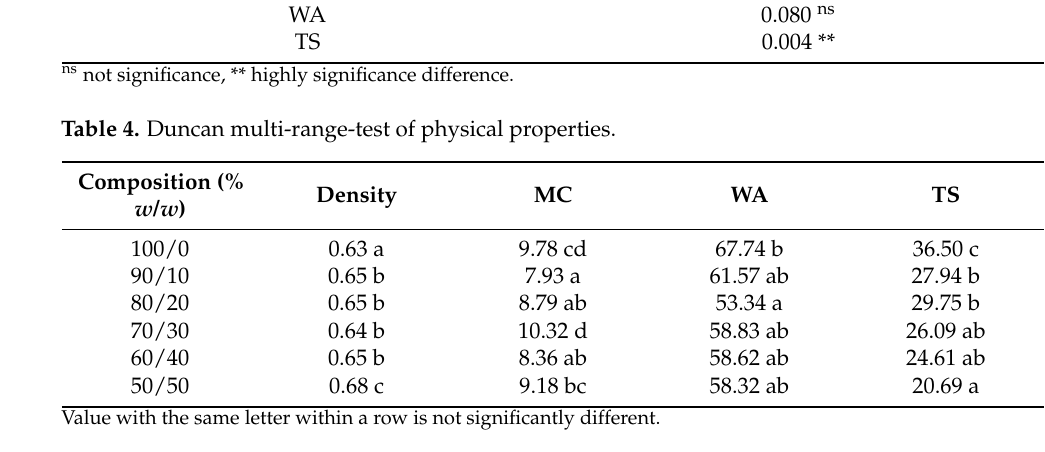
Table 5. Particleboard spring back